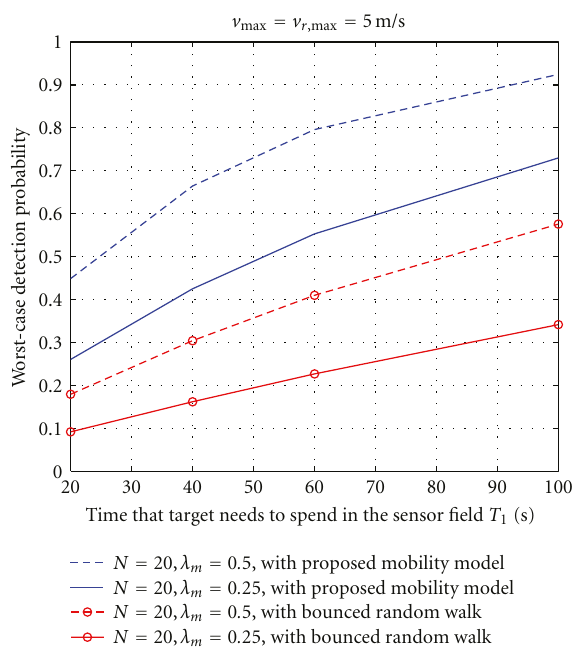
Figure 14: Worst-case detection performance, v max = v r ,max = 5m/s, b ≈